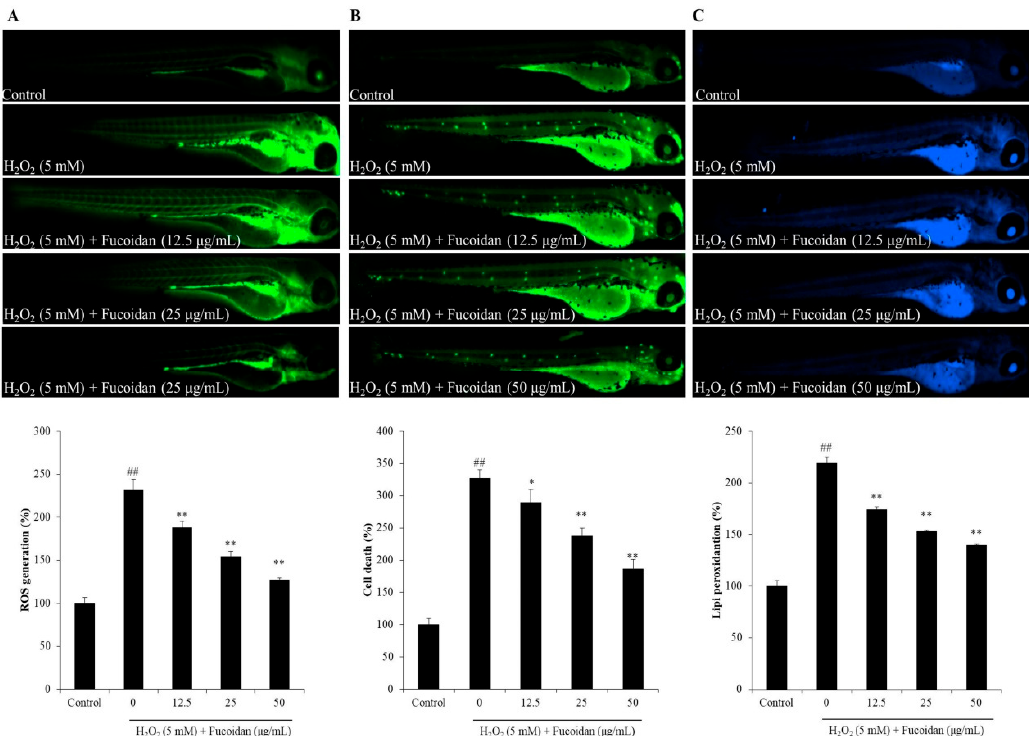
Figure 6. The effect of fucoidan on H 2 O 2 -induced ROS generation, cell death, and lipid peroxidation in zebrafish. ( A ) The protective effect of fucoidan against H 2 O 2 -induced ROS generation; ( B ) the protective effect of fucoidan against H 2 O 2 -induced cell death; ( C ) the protective effect of fucoidan against H 2 O 2 -induced lipid peroxidation. The relative fluorescence intensities of zebrafish were determined using Image J software. The experiments were conducted in triplicate, and the data are expressed as the mean ± SE. * p < 0.05, ** p < 0.01 as compared to the H 2 O 2 -treated group and ## p < 0.01 as compared to the control group.